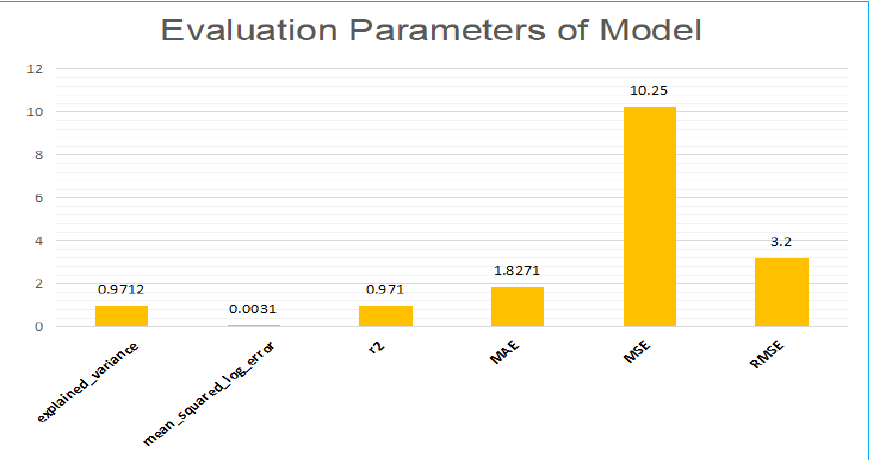
Figure 13. Random Forest Regressor Parameters.